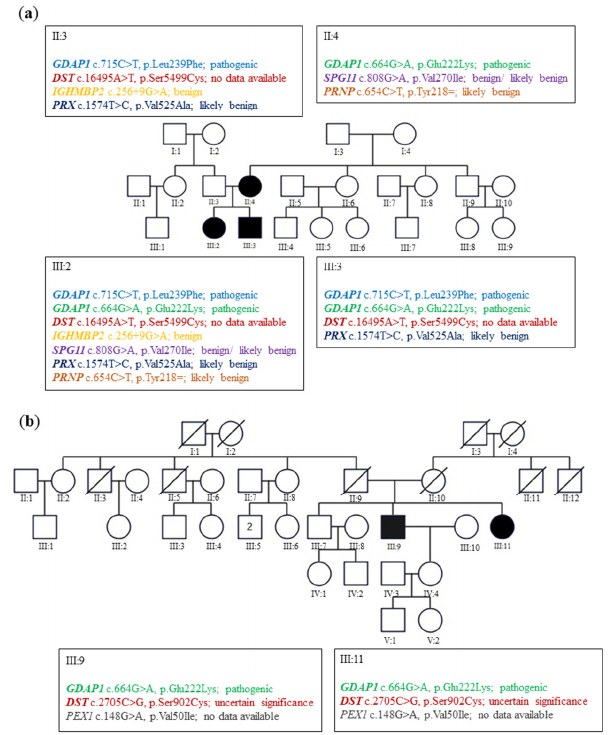
Figure 1. Pedigrees of the studied families A and B. ( a ) In family A, the p.Glu222Lys variant was found in the II:4 in a heterozygote and III:2 and III:3 in the compound heterozygosity with p.Leu239Phe. ( b ) In family B, the heterozygous p.Glu222Lys variant was found in III:9 and III:11. In both families, some additional sequence variants in CMT genes: DST (encoding Dystonin), IGHMBP2 (Immunoglobulin Mu DNA Binding Protein 2), PRX (Periaxin), SPG11 (SPG11 Vesicle Trafficking Associated, Spatacsin), PRNP (Prion protein) and PEX1 (Peroxisomal Biogenesis Factor 1) were found with the use of WES. Circles mark women, squares mark men, the crossed-out symbol means a deceased person, black symbols mean sick people, and a number in a square represents the number of healthy people of a given sex. Roman numerals indicate generation, and Arabic numerals indicate successive persons in a given generation.